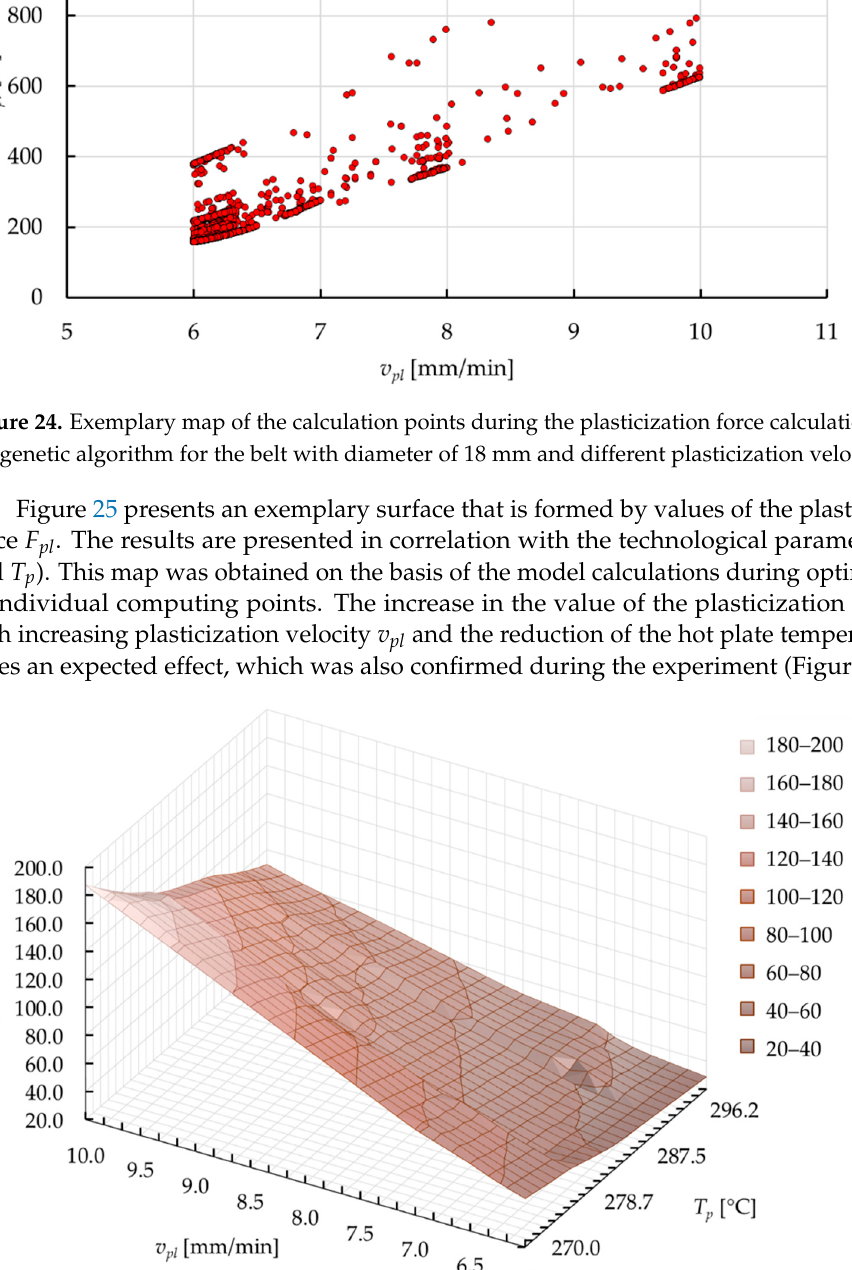
Figure 23. Exemplary view of the connection between particular parameters during optimization using MS Excel and Simulia Isight software.